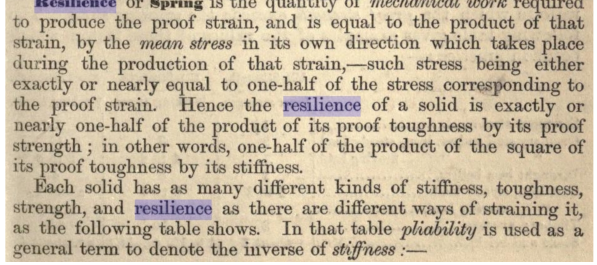
Fig. 5. William Rankine defined resilience for mechanics in